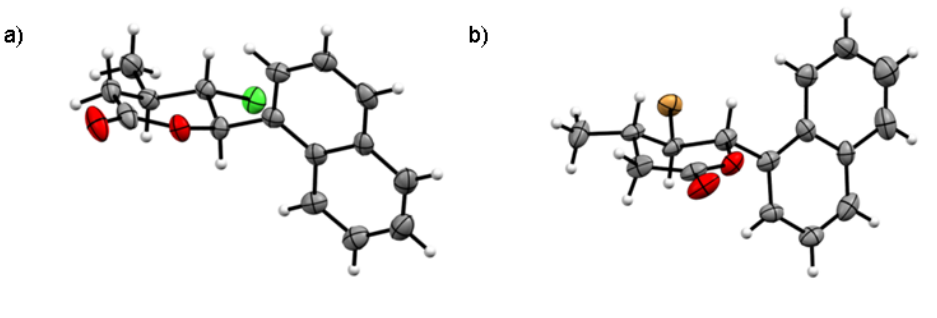
Figure 5. The crystalline structure of: ( a ) trans,trans - γ -chloro- δ -lactone 5a ; and ( b ) trans,trans - γ -bromo- δ - lactone 7a .